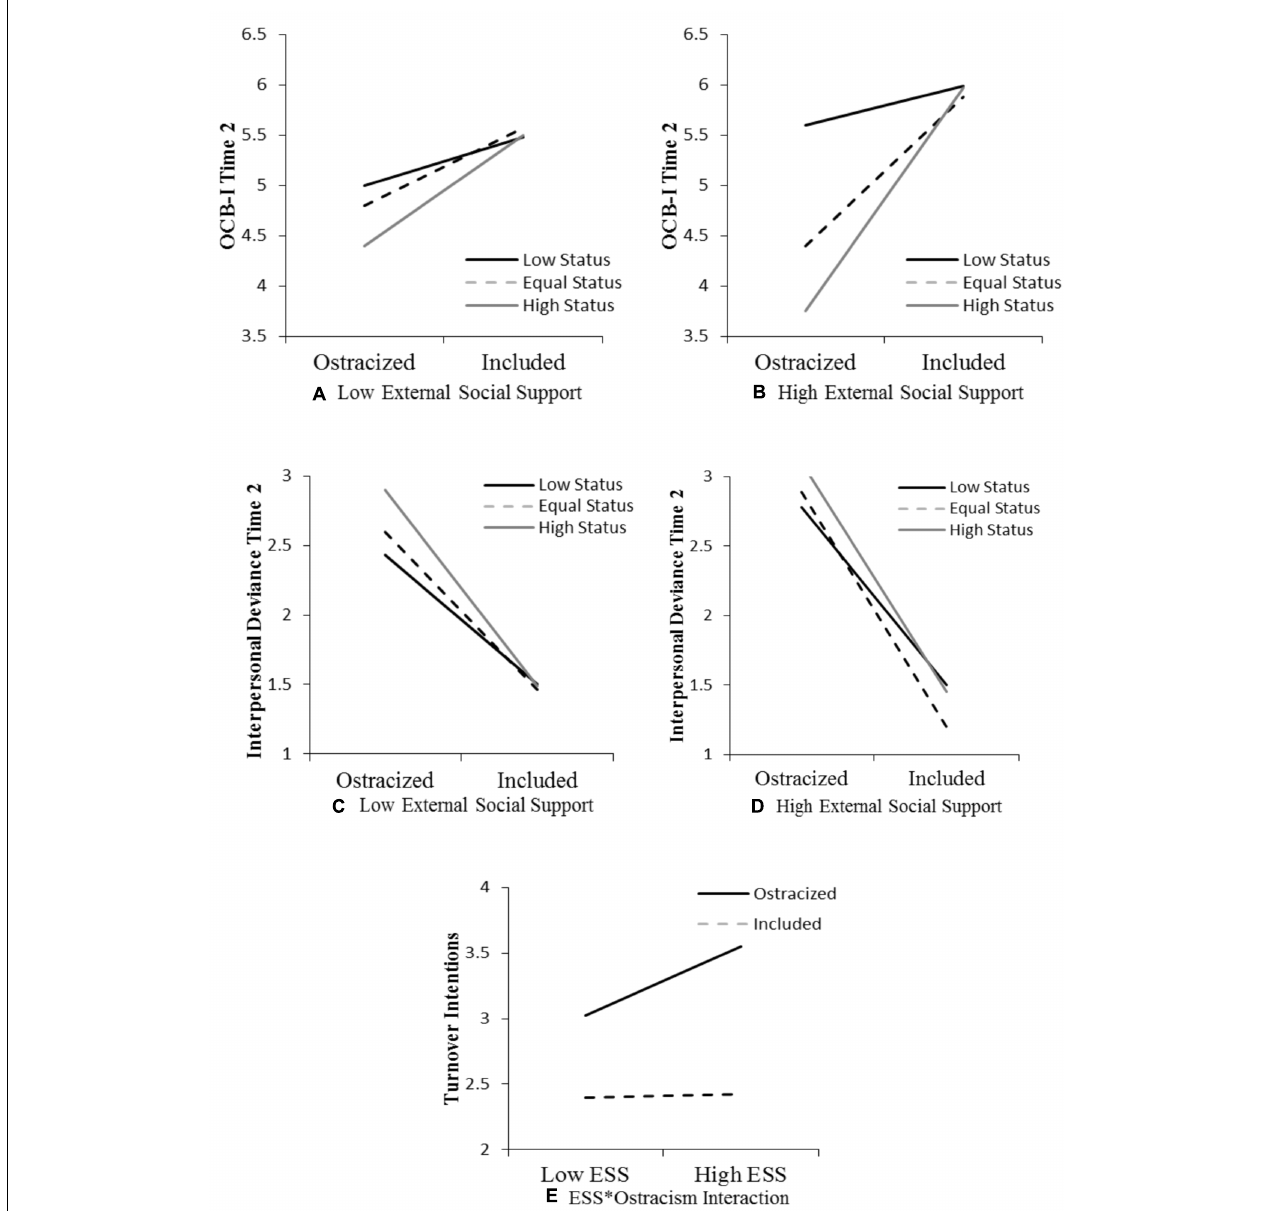
FIGURE 2 | Study 2: Moderation effects of ostracizer status and external social support. OCB-I, organizational citizenship behavior-individual; ESS, external social